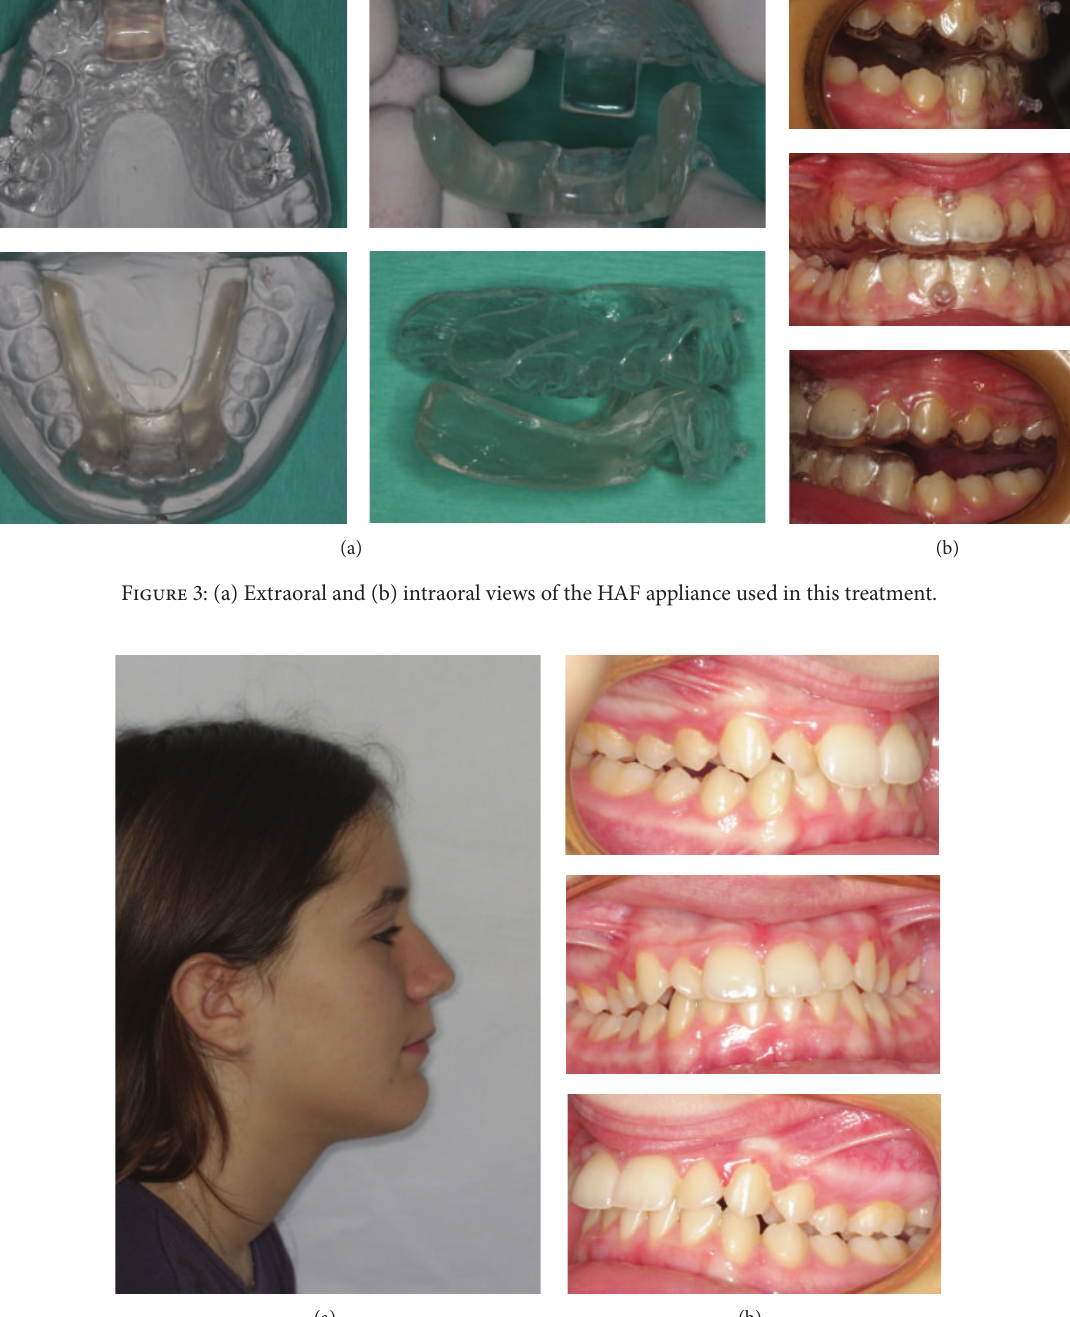
of acrylic parts to enhance esthetics. By means of a special plier, buttons are formed at the cervical third of upper and lower dental midlines to enable night-time wear of vertical elastics. Alternatively, light-cured composite resin combined with appropriate transparent matrices can be used for button